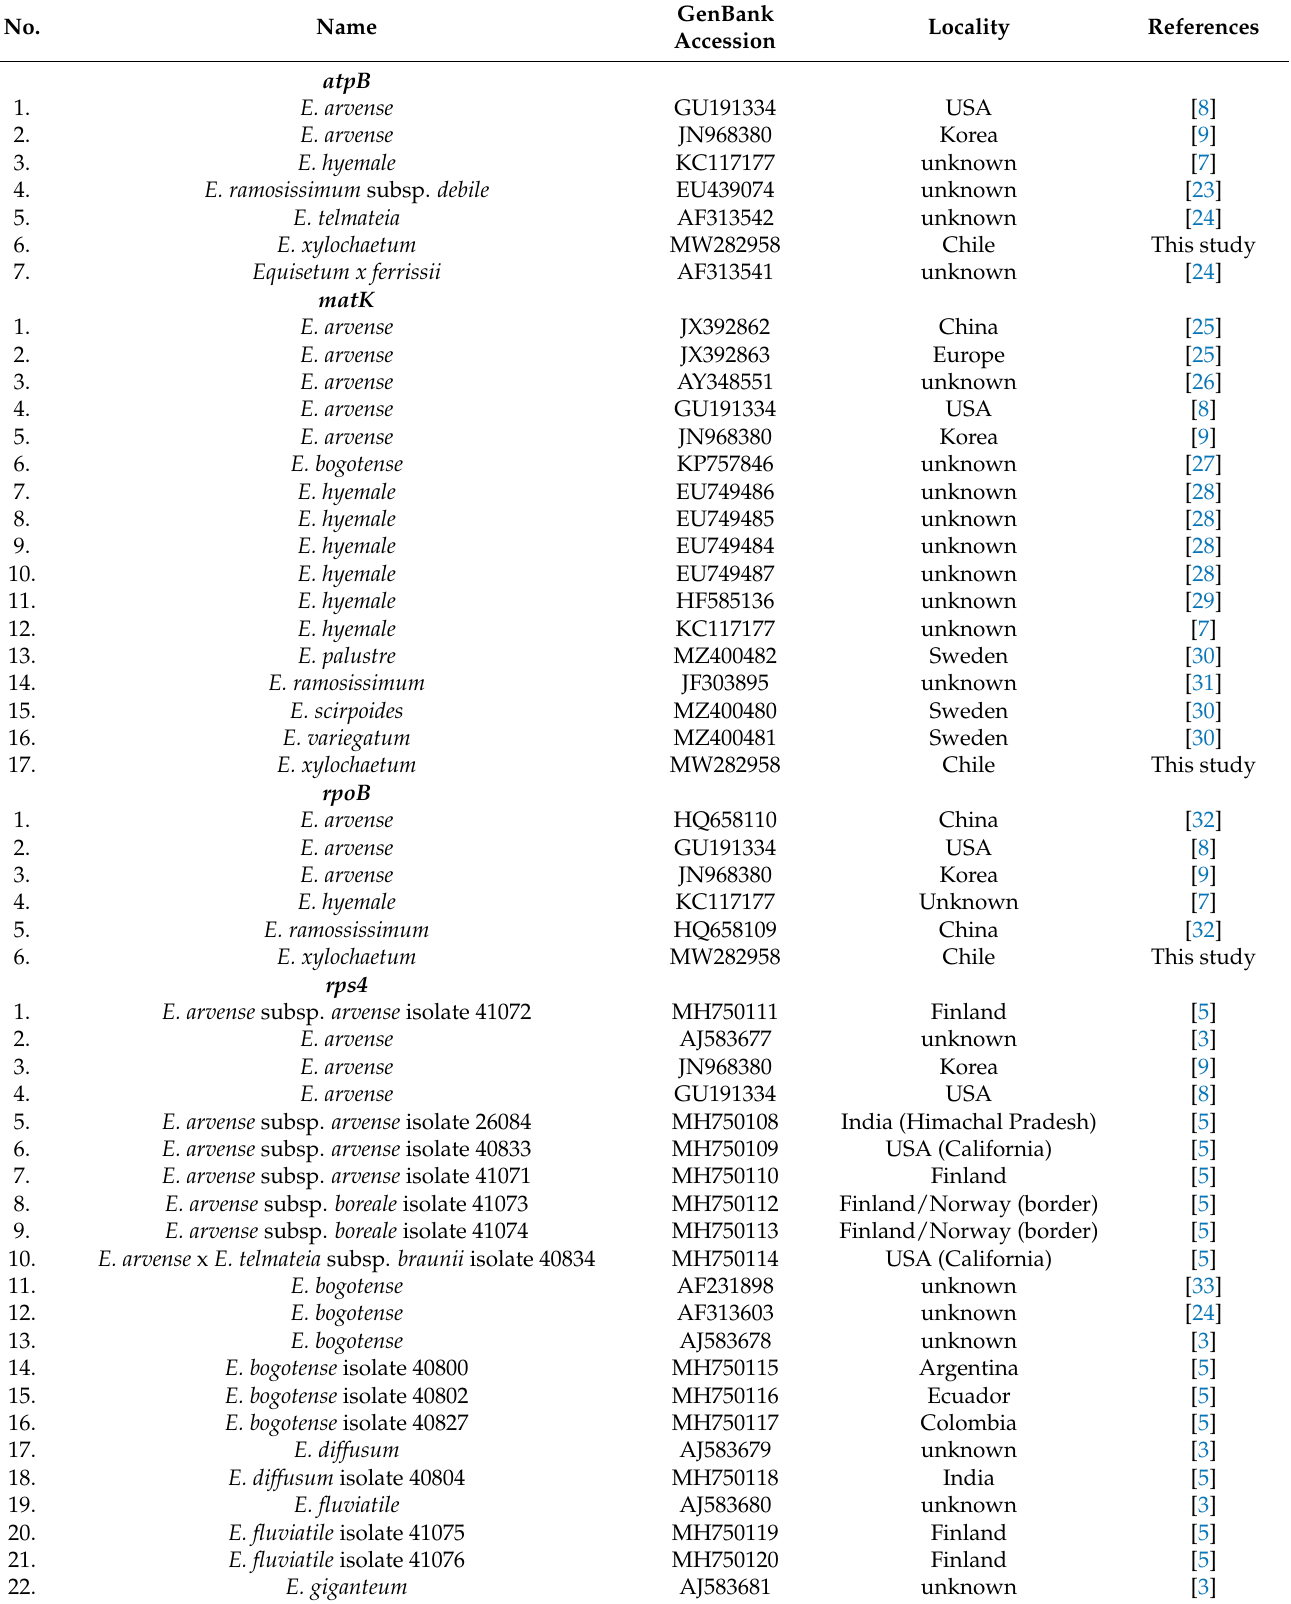
Table 3. Nucleotide sequences used in the single gene phylogenetic analysis and TCS haplotype